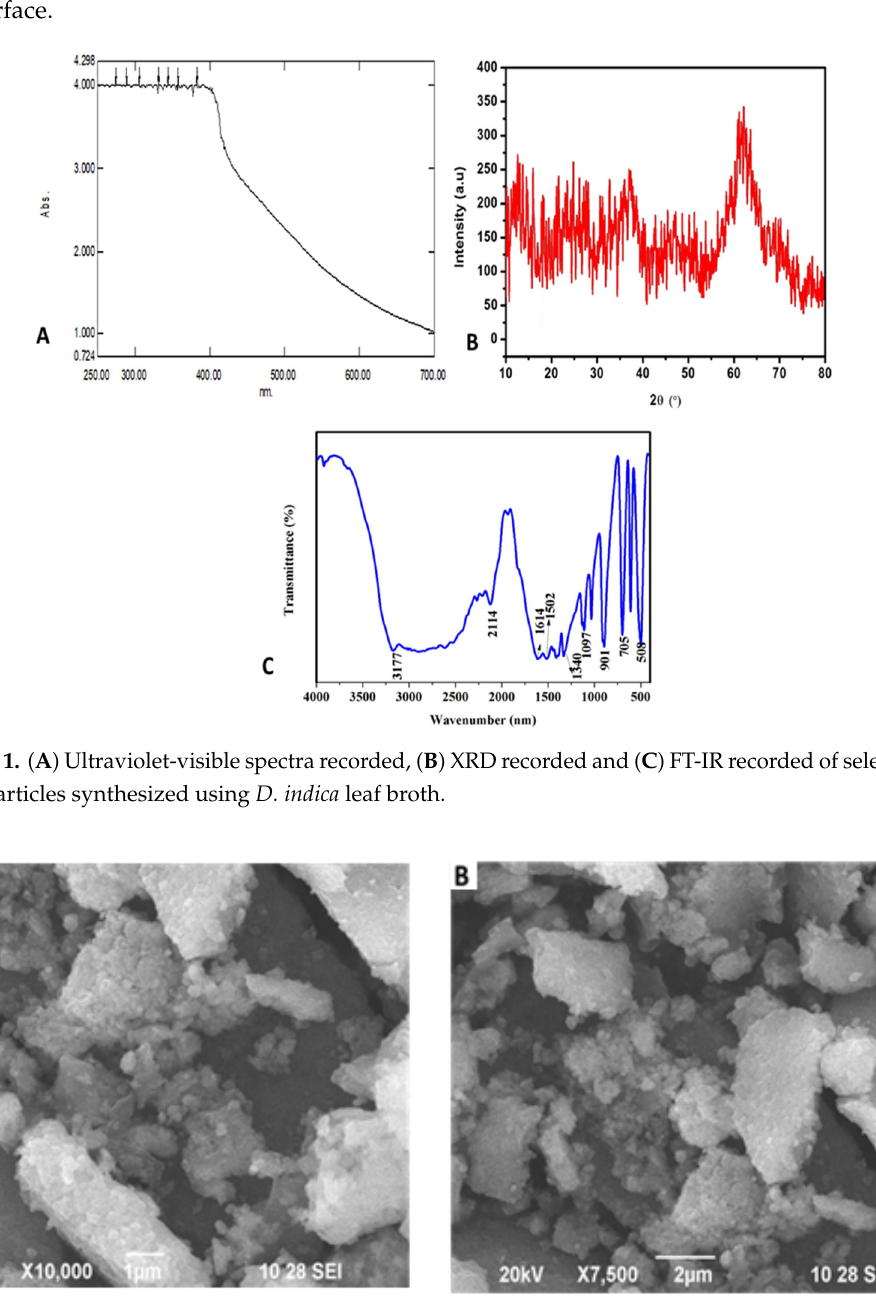
Figure 2. SEM images of selenium nanoparticles synthesized using D. indica plant broth. ( A ) 1 µm view, ( B ) 2 µm view.